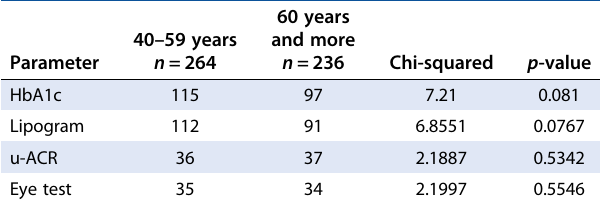
Table 2: Screening tests for complications Test performed